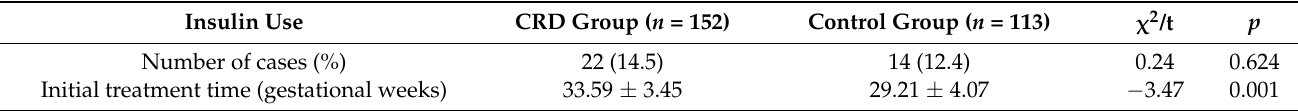
Table 3. Comparison of insulin treatment rate and the initial gestational